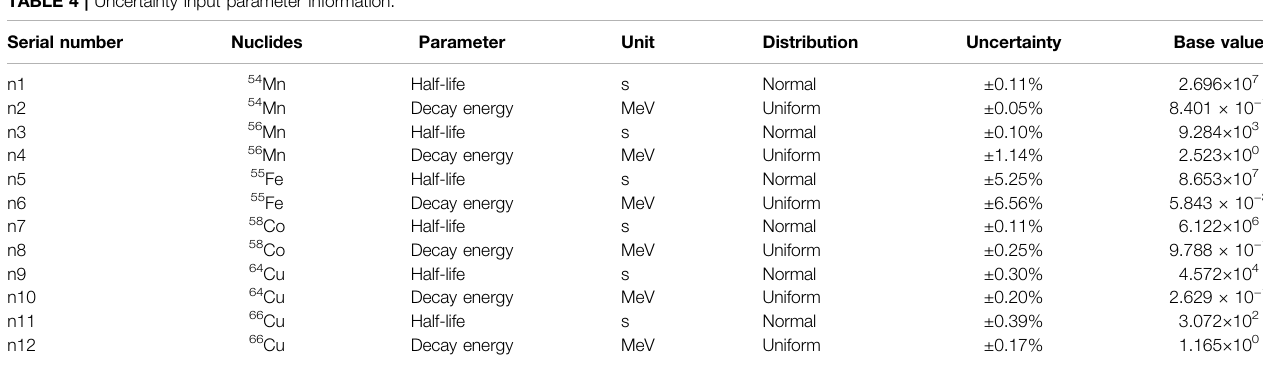
TABLE 4 | Uncertainty input parameter